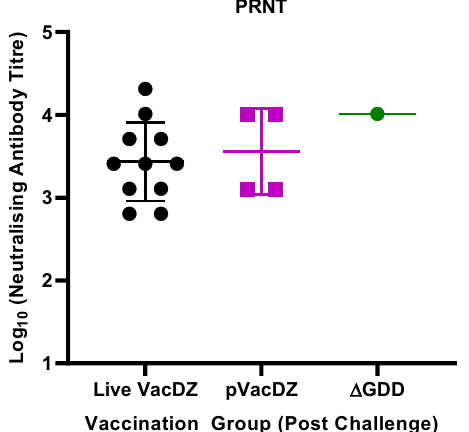
Fig. 7 ZIKV neutralising antibody titres in vaccinated AG129 mice post challenge. 5-8 weeks old AG129 mice were inoculated intraperitoneally with a single dose of the indicated vaccines (or their respective control). Four weeks after vaccination, they were challenged with a lethal dose of 10 5 PFU of ZIKV per mouse. The mice were kept for four weeks and observed daily for clinical symptoms and killed when they reached a humane endpoint. Four weeks after lethal challenge, serum was harvested from the surviving mice. ZIKV neutralising antibody titres were determined using PRNT, and is de fi ned as the highest serum dilution that reduced the ZIKV plaque count by at least 50% in three technical replicates. Each point represents the neutralising antibody titre for one mouse. N numbers are for the number of mice surviving four weeks after lethal challenge. Live VacDZ dose was 10,000 PFU per mouse, n = 11. pVacDZ: DNA-launched VacDZ, dose was 80 μ g of pVacDZ and 20 μ g of pTet-Off Advanced per mouse, n = 4. Δ GDD: pVacDZ- Δ GDD replication defective mutant, dose was 80 μ g of pVacDZ- Δ GDD and 20 μ g of pTet-Off Advanced per mouse, n =